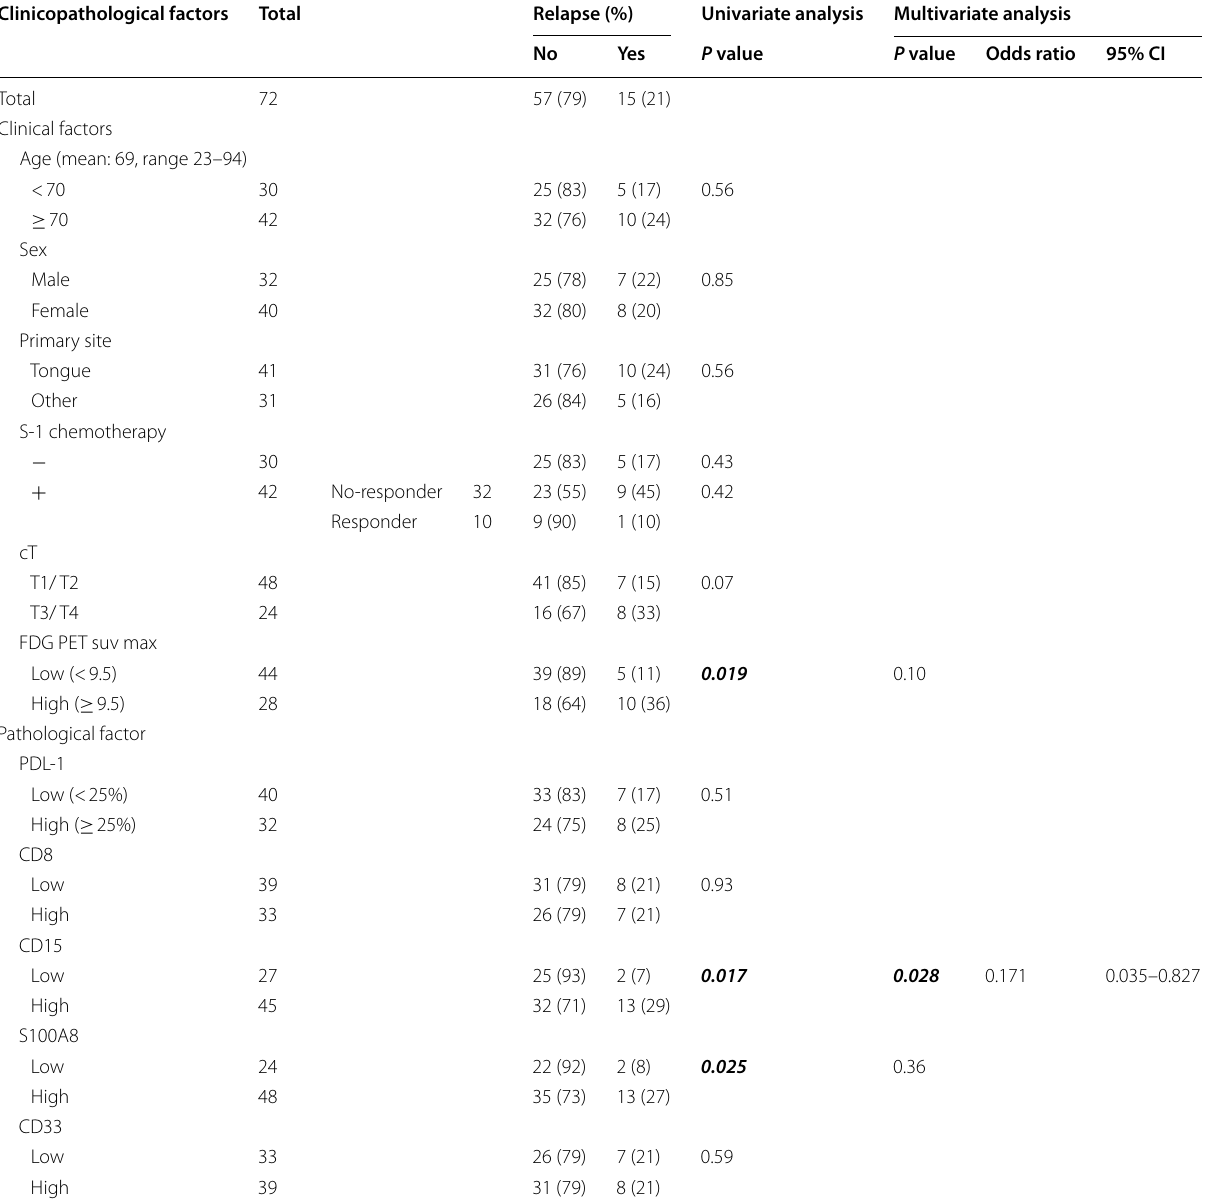
Table 1 Univariate and multivariate analysis of clinical and pathological variables for relapse